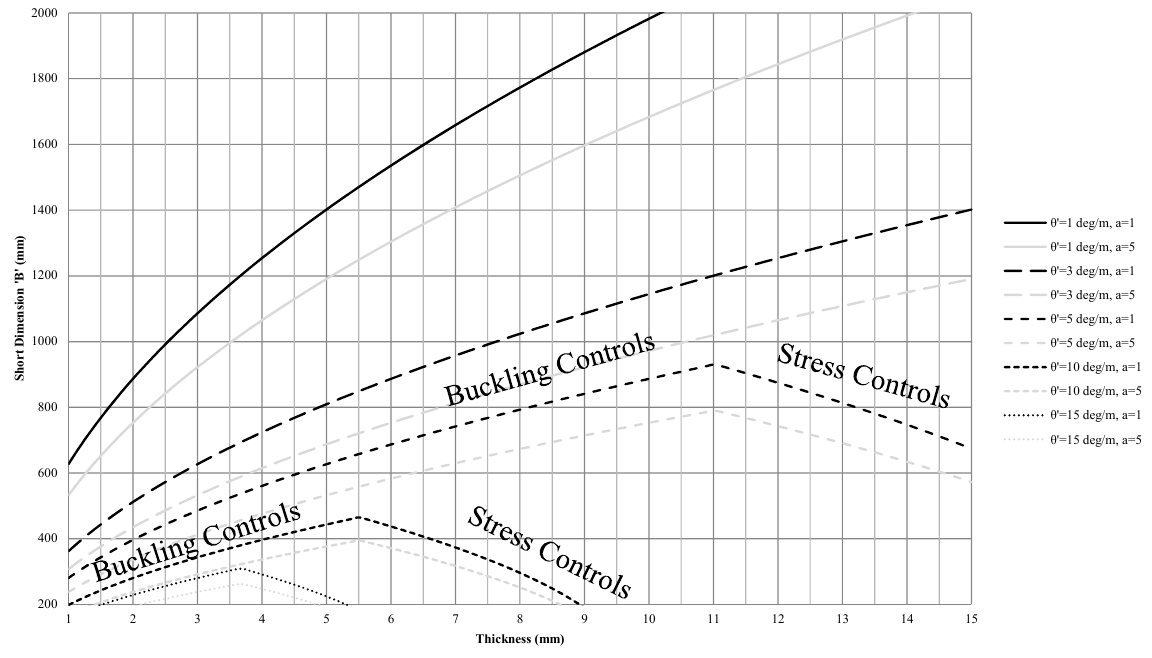
Fig. 16 Contours of Maximum Differential Twist Allowed per Short Dimension and Thickness